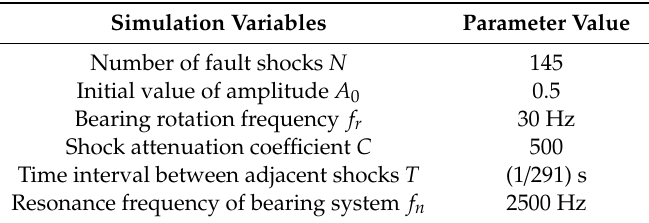
Table 1. Simulation parameters of rolling bearing fault model.